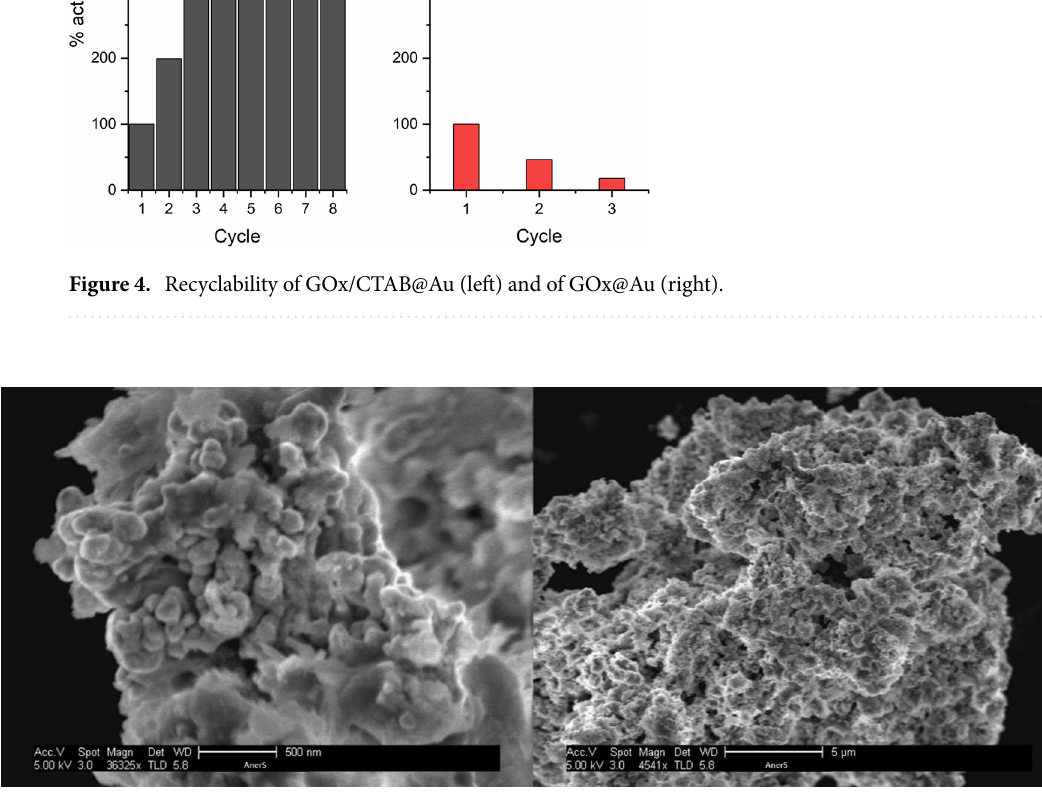
Figure 5. HR-SEM images of GOx/CTAB@Au (bars: left 500 nm, right: 5